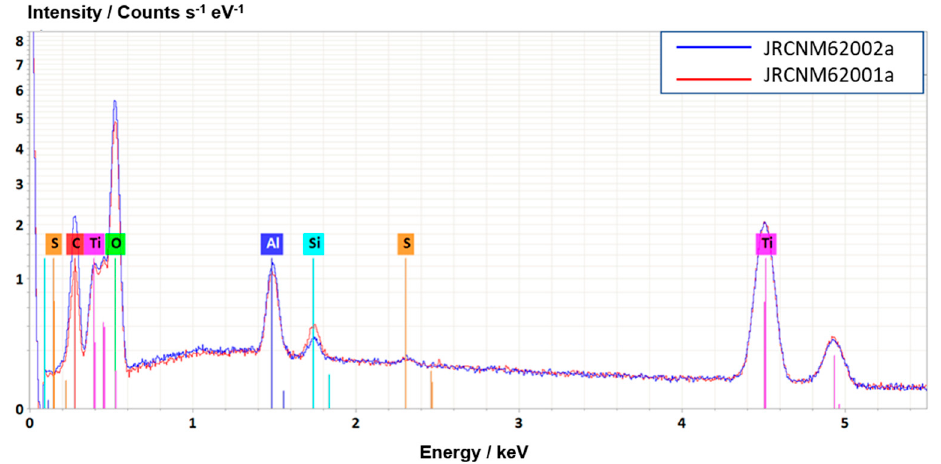
Figure 4. The 10 kV EDS spectra of the titanium dioxide nanoparticles from Figure 3 taken from sample areas of 8 µ m × 8 µ m: JRCNM62001a (blue) and JRCNM62002a (red). The samples were prepared as dry powder on a silicon wafer. The two spectra have been normalized to the intensity of the Ti K α peak.